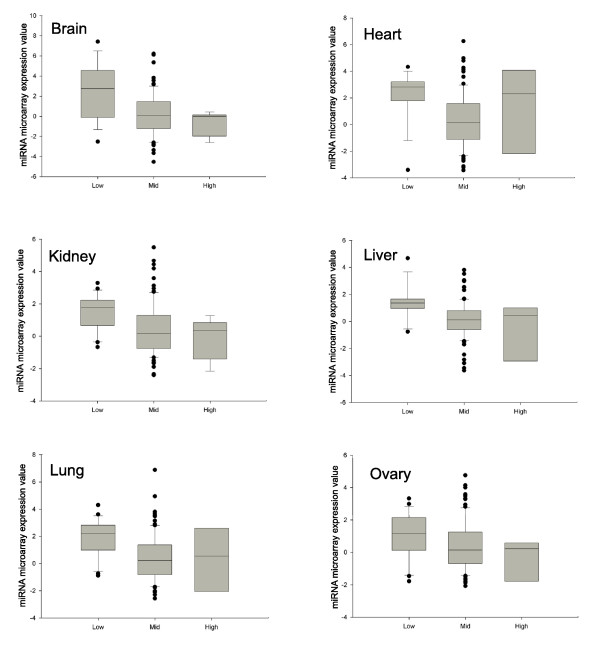
Correlation between miRNAs with predicted effects on mRNA expression and miRNA expression levels detected by miRNA microarrays. miRNAs were divided into those with significantly lower than expected target mRNA expression (labeled 'low'), those with no detectable effect on their target expression (labeled 'mid') and those with significantly high target expression (labeled 'high'). The boxplots show the expression values (y-axis), determined by Thomson et al. [33], of the miRNAs in each group (x-axis). The expression of miRNAs with low target gene expression is significantly higher (t-test, p < 0.05) than that of those with mid or high target expression (in all tissues except heart). Thomson et al. [33] labeled the microRNAs from each tissue with Cy3 and used a reference oligonucleotide set corresponding to all mature microRNAs, labeled with Cy5 (red channel) in all hybridizations. This reference set provided an internal hybridization control for every probe on the array. The miRNA microarray expression values used in our analyses are median centered normalized log ratio Cy3/Cy5 values.